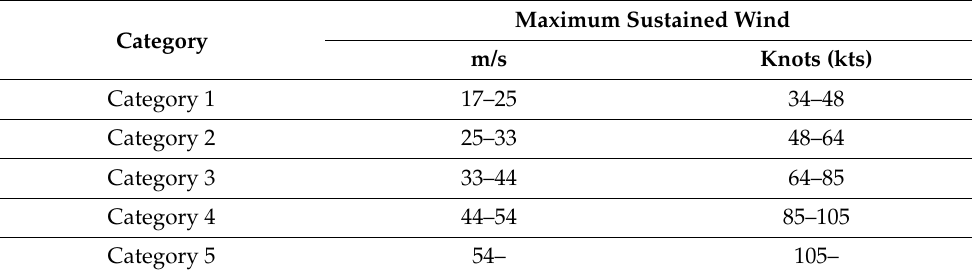
Table 2. Intensity categorization of tropical cyclones according to the standard from the Korea Meteorological